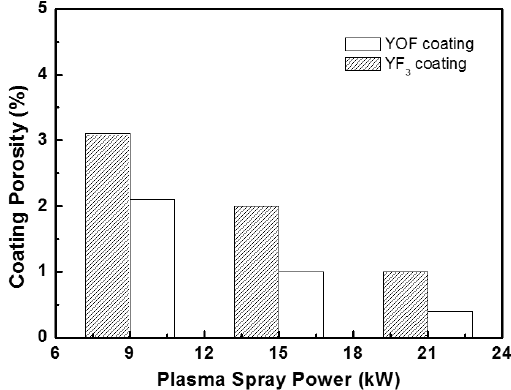
Figure 5. Porosities of the YOF and YF 3 coatings obtained under different plasma-spray powers.